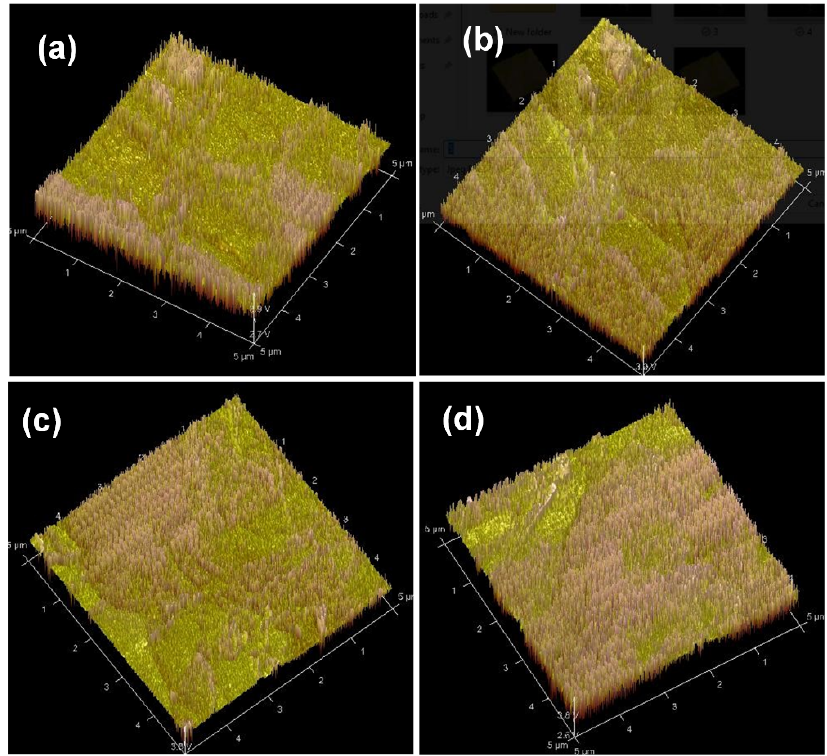
Figure 5. Atomic force microscopy (AFM) topographic images revealing major structural differences at the surface of P3HT:PCBM:Nb photoactive layers prepared using different doping Nb nanoparticles of ( a ) 2, ( b ) 4, ( c ) 6, and ( d ) 8 mg/mL.